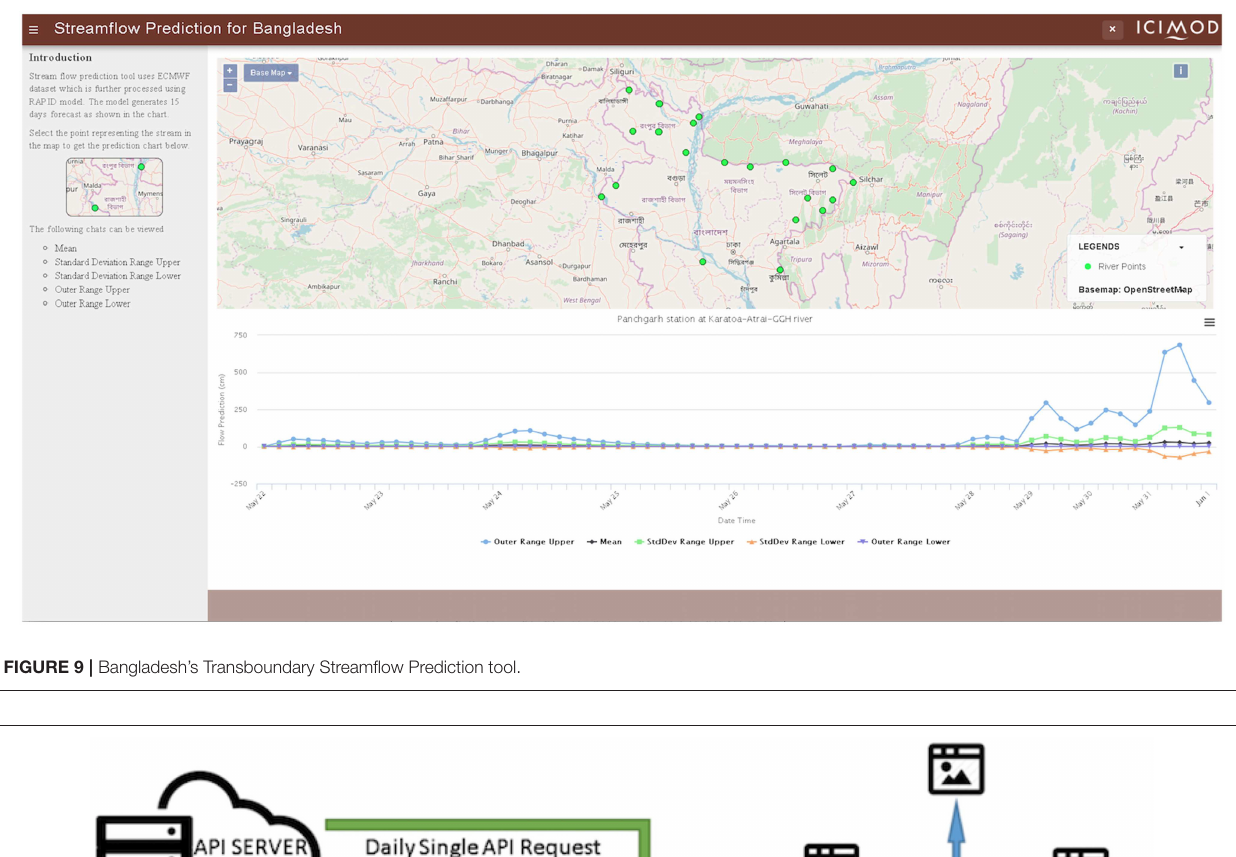
FIGURE 9 | Bangladesh’s Transboundary Streamflow Prediction tool.